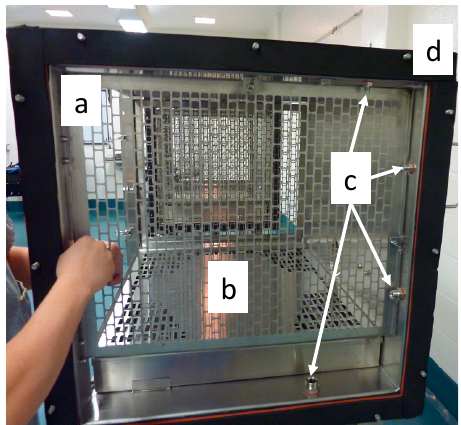
Figure 2. Side view of a cage. ( a ) Perforated grates on each side of the cage, ( b ) excreta pan with a perforated lid, ( c ) sampling ports, ( d ) rubber seal between cages.